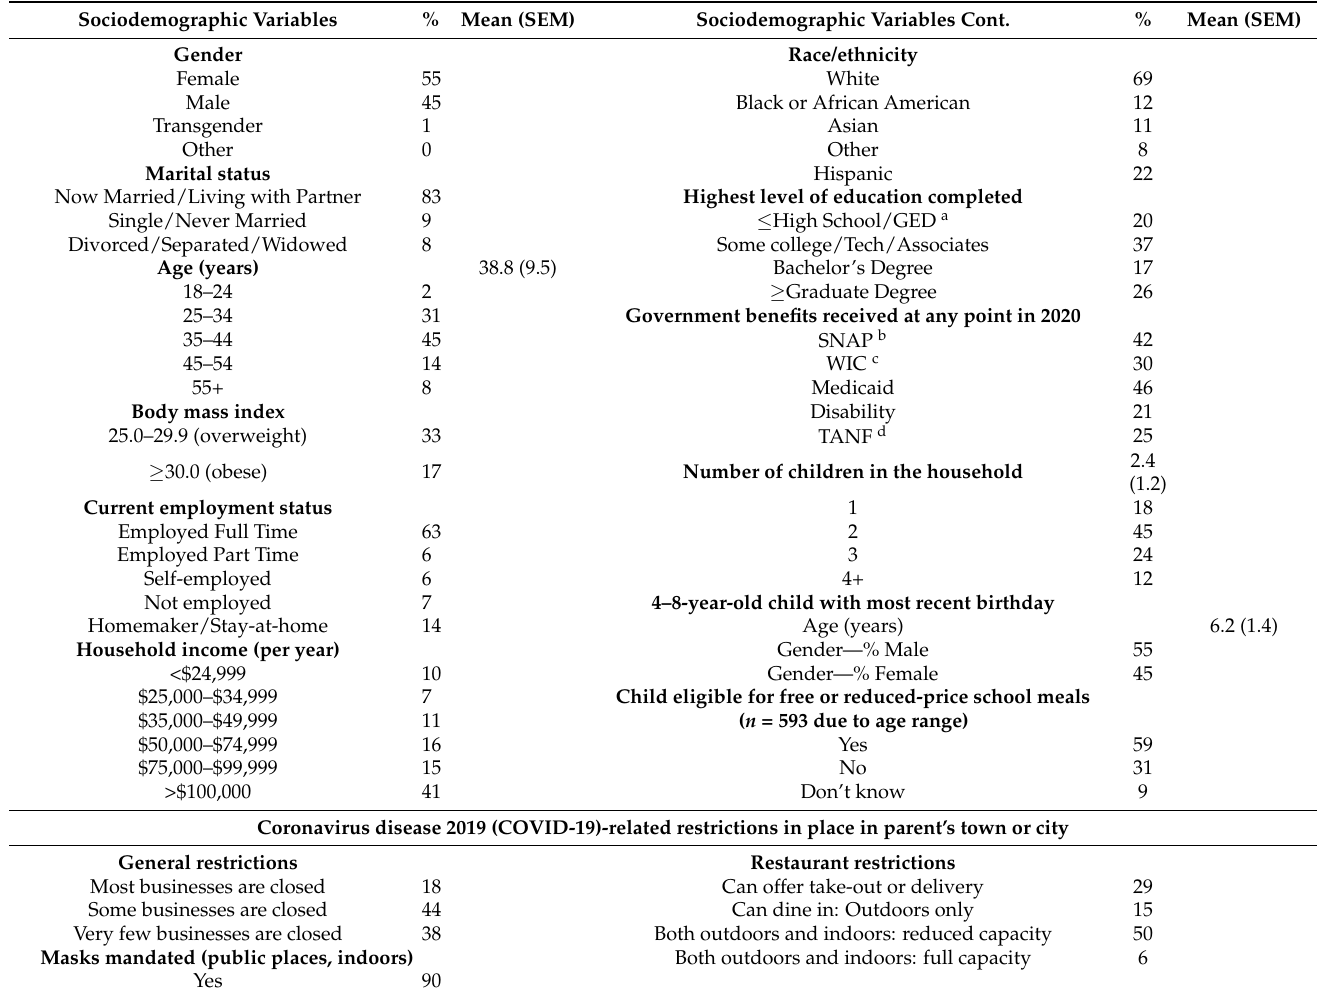
Table 1. Participant characteristics for study sample ( n = 1000) (weighted frequencies and